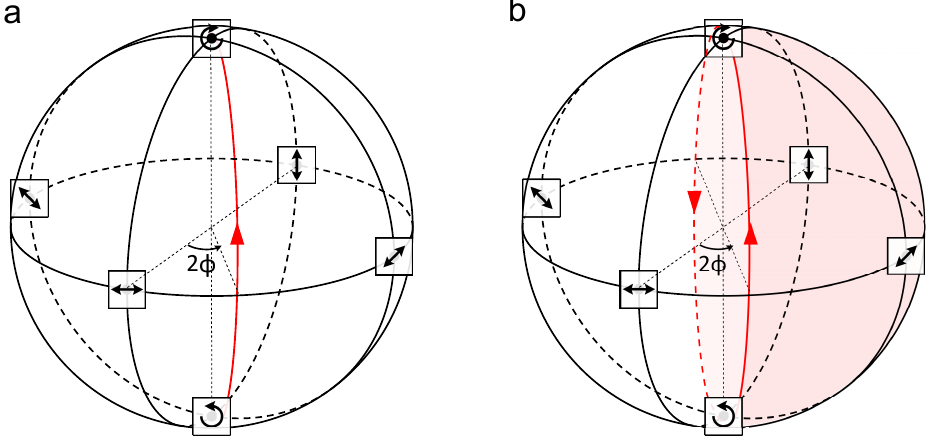
Figure 1. Poincaré sphere representation of the transformations J (cid:48) E − ( a ) and J (cid:48) J (cid:48) E − ( b ). Note that only panel b is representing a closed